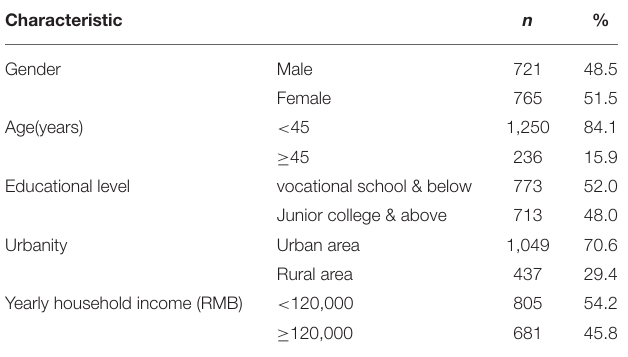
TABLE 1 | Characteristics of participants ( n = 1486). TABLE 2 | Means, standard deviations, and correlations of the major study